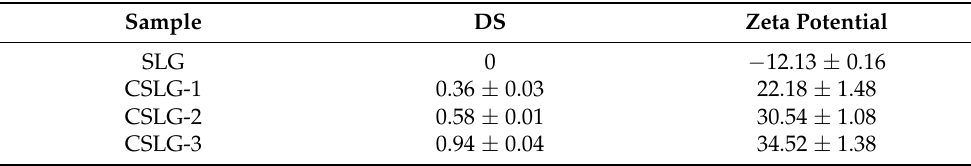
Table 1. Degree of substitution and zeta potential of SLG and